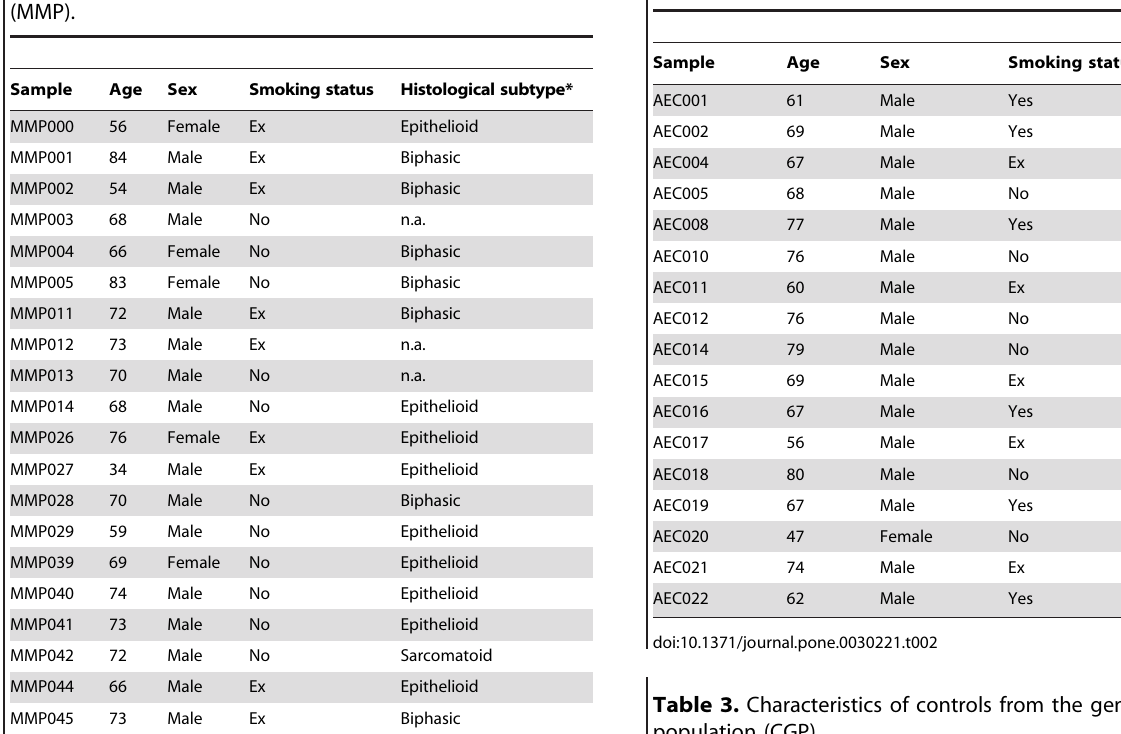
Table 2. Characteristics of asbestos-exposed controls (AEC).